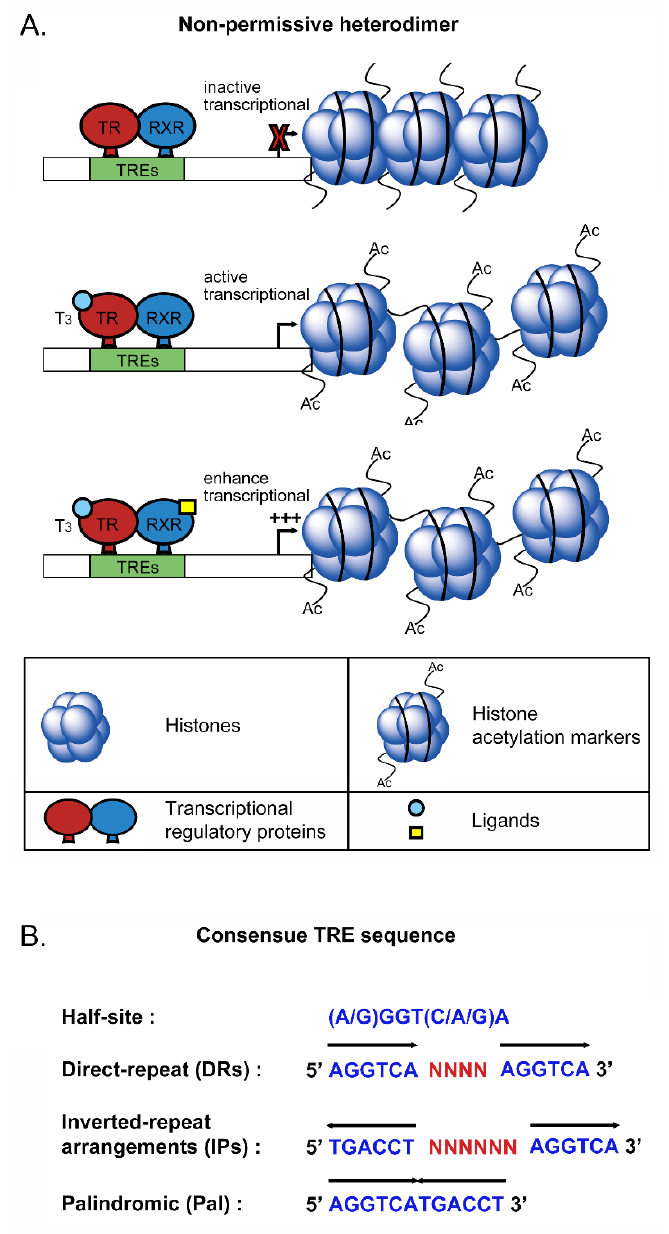
Figure 2. Schematic representation of TRs / RXR non-permissive heterodimers and consensus TRE half-sites. ( A ) TRs / RXR belong to non-permissive heterodimers that can be activated transcriptionally by TRs ligand but not by RXR ligand alone. Moreover, TRs / RXR can enhance the transcriptional response by binding of the RXR ligand and TRs ligand. ( B ) TREs within the promoter region contain individual DNA sequences (A / G)GGT(C / A / G)A, designated “half-sites”, that are recognized by TRs. The half-site sequences in TREs incorporate palindromic (Pal), direct repeat (DR) and inverted repeat arrangements (IP).